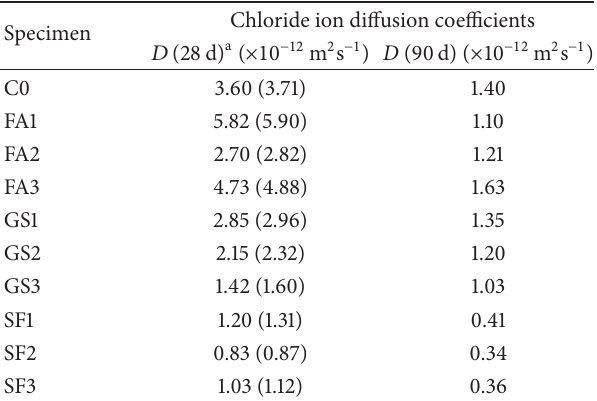
Table 2: Test results of the chloride ion diffusion coefficients.